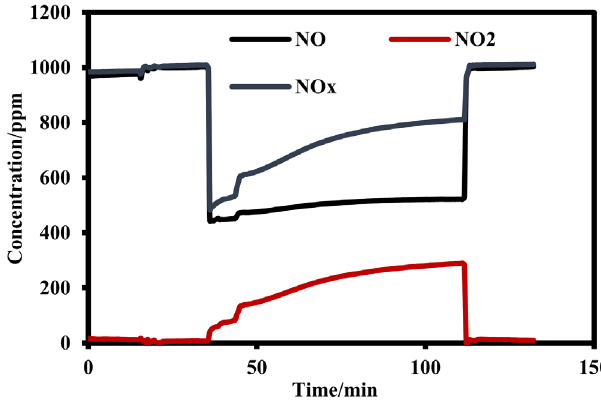
Figure 3. The curve of NO x gas concentration in the process of photocatalysis.